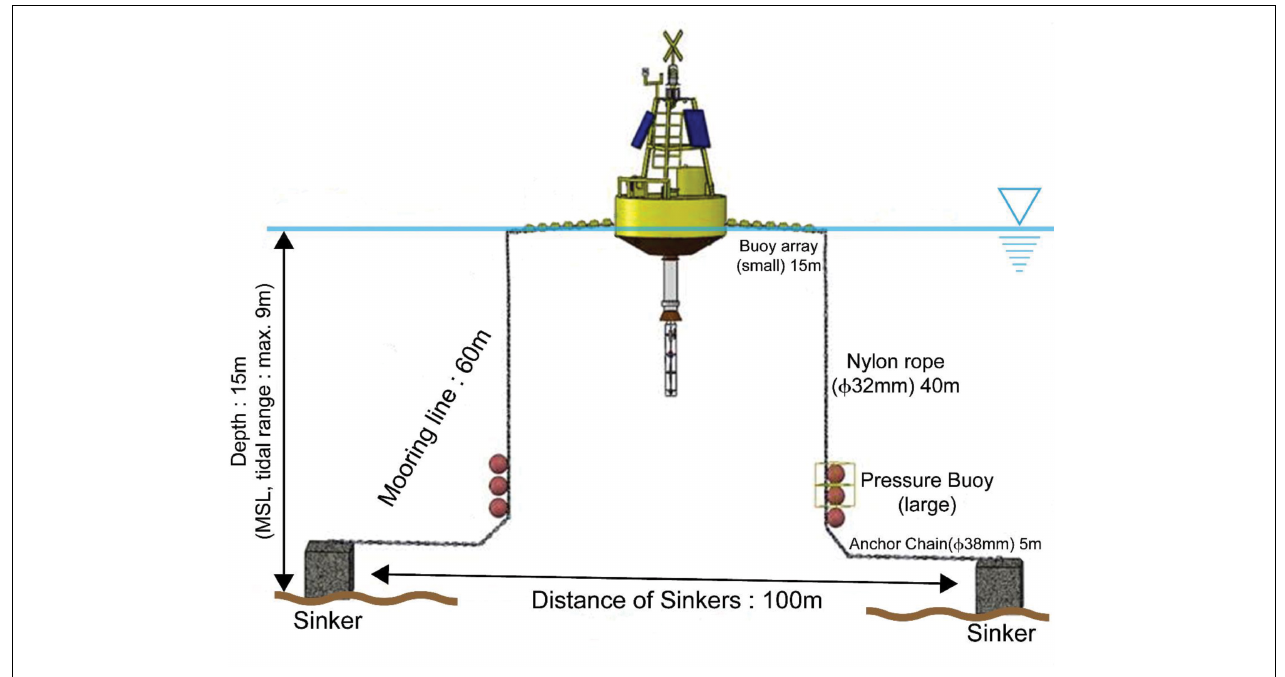
FIGURE 6 | Intelligent Buoy System (INBUS)-2 mooring